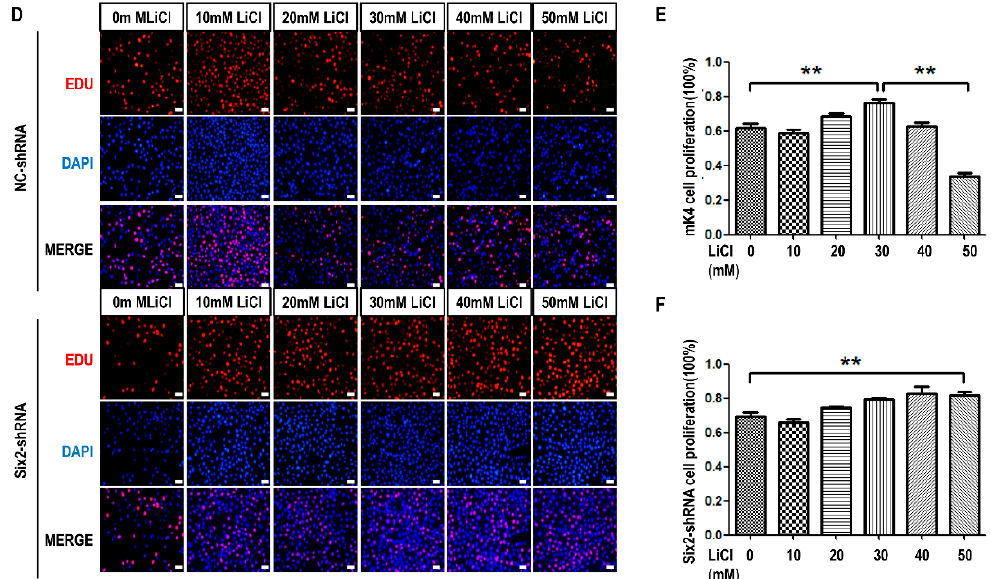
Figure 4. Knockdown of Six2 gene inhibits cell proliferation while LiCl treatment of low-concentration promotes cell proliferation in mK3 and mK4 cells. ( A ) mK3 cells were transfected with negative shRNA control and Six2 -shRNA for 36 h and treated with LiCl of increasing dosages for 12 h. Proliferating mK3 cells were labeled with EdU (red) and cell nucleus were stained with hoechst (blue). The EdU results were accessed by fluorescent microscope (200×) with the scale bar representing 20 µm and the respective pictures were merged to the purple one; ( B , C ) Statistical analysis of cell proliferation. Values were presented as mean ± SEM ( n = 3), ** p < 0.01, *** p < 0.001 relative to control; ( D ) mK4 cells were transfected and were detected by EdU assay as same as mK3 cells in ( A ); ( E , F ) Statistical analysis of cell proliferation. Values were presented as mean ± SEM ( n = 3), ** p < 0.01 relative to control.